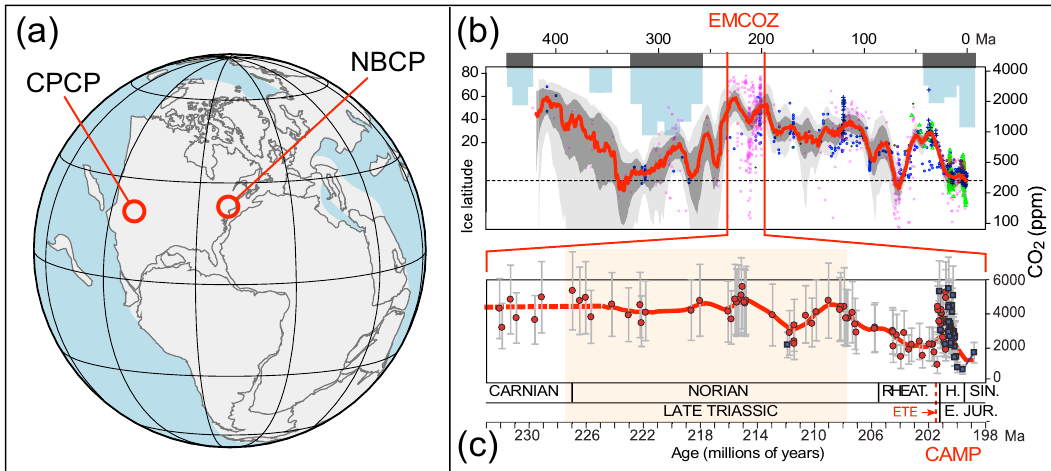
Figure 1. Context for the CPCP cores. (a) Late Triassic–Early Jurassic Pangea showing the positions of CPCP cores and Newark Basin Coring Project (NBCP) APTS (based on Whiteside et al., 2010). (b) Compilation of CO 2 proxy data and extent of continental ice modified from Foster et al. (2017) with latitudinal extent of ice (light blue bars) and ice-house conditions (grey bars). Proxy symbols are leaf stomata, blue open circles; pedogenic carbonate, pink crosses; boron isotopes, green triangles; liverworts, blue filled circles; and alkenones, blue crosses – red line is fit through the data and 68% and 95% confidence intervals are dark and light grey bands. (c) The Early Mesozoic CO 2 Zenith (EMCOZ), based on the pedogenic CO 2 proxy from the Newark and Hartford basins, modified from Schaller et al. (2015): red circles are from the Newark Basin and blue circles are from the Hartford Basin; light orange area is interval encompassed by the Chinle Formation in CPCP cores; red line is the smoothed fit through the data; and the dashed red line mean for the points without astrochronologic time